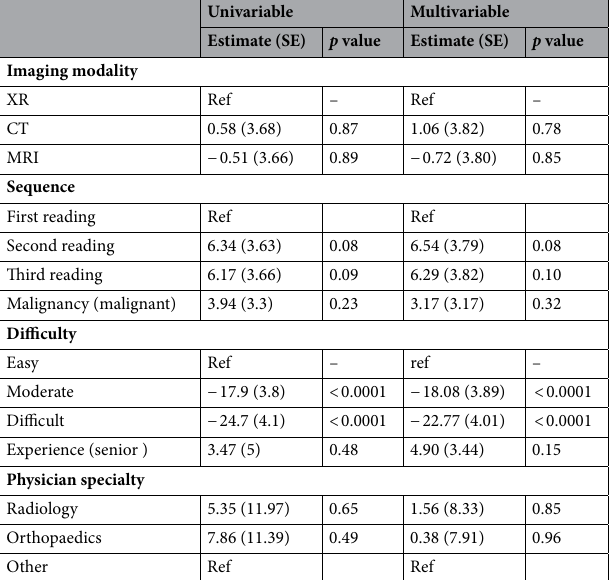
Table 5. Univariable and multivariable mixed regression models for the probability of correct diagnoses. *All univariable models were adjusted for reader as a random